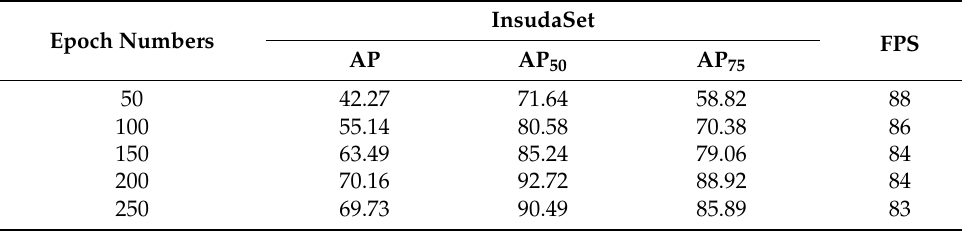
Table 8. Comparison table of results for setting different epoch numbers.